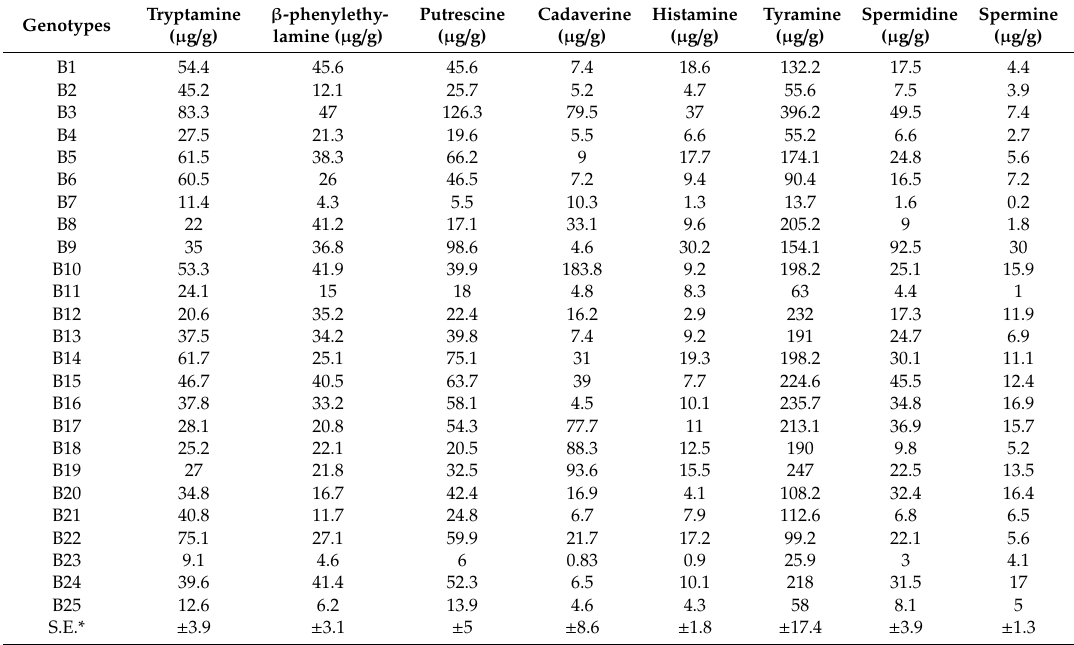
Table 1. The list of amine concentrations in Prosopis juliflora genotypes from the Al-Qassim region, Saudi Arabia (Source: Al-Soqeer et al.